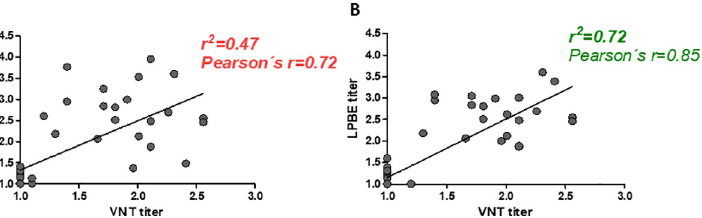
Fig 6. Impact of binding the presence of 12S particles in the correlation with VNT titers. LPBE was performed either with a virus suspension (A) or whole-purified 146S particles (B). Titers were computed and plotted against their corresponding neutralizing titers. Each point depicts an individual sample. Linear correlation coefficients (r2) and Pearson´s r values are shown in each graph. Values in red depict a poor correlation between VNT and LPBE titers.